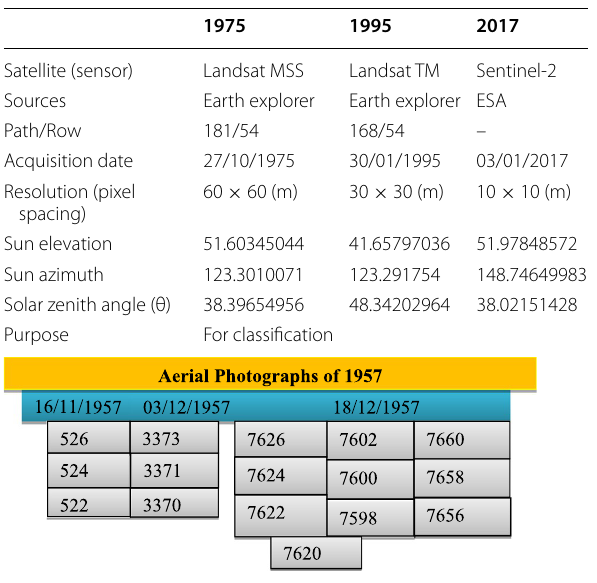
Table 1 Descriptions of used aerial photographs and satellite